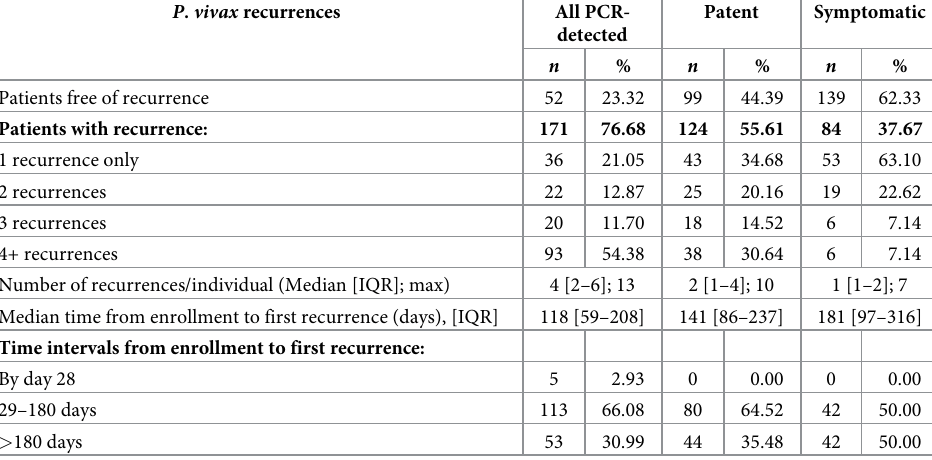
Abbreviations : IQR, Interquartile Range; PCR, polymerase chain